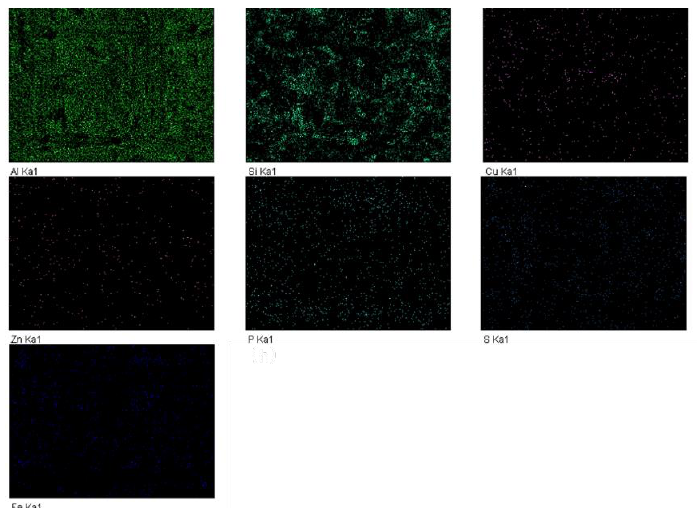
Figure 13. Element distribution of the worn surface.